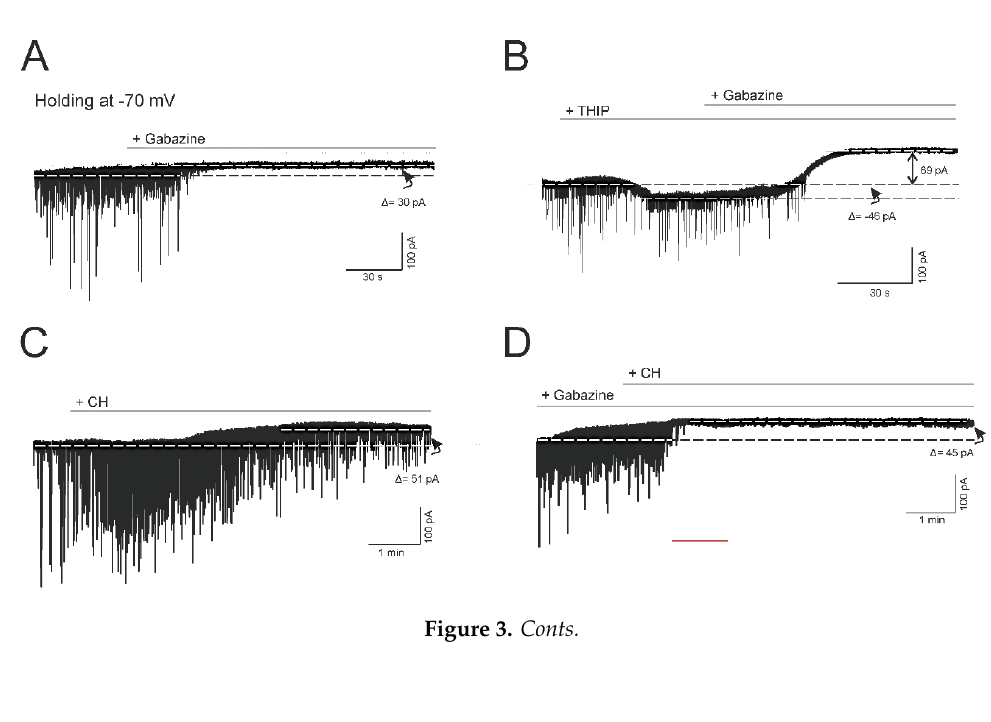
Figure 3. Effects of gabazine and cumene hydroperoxide (CH) on the holding current of pyramidal neurons from the motor cortex in infantile rats. ( A ) . The application of gabazine 20 μM ( n = 6) in the presence of glutamatergic antagonists blocked the spontaneous inhibitory postsynaptic currents (sIPSC) and revealed a tonic current mediated by the gabazine (GABA A ) receptor (30 pA for the illustrated neuron). ( B ). Changes in the holding current after THIP application (an agonist of GABA A extrasynaptic receptors) and after THIP plus gabazine in the same cell ( n = 6). These experiments were carried out to check the presence of extrasynaptic receptors in this pool of neurons. ( C ). Effect of CH on the membrane current. Note that the application of CH in the presence of CNQX and AP5 produced an outward shift in the holding current when the holding potential was held at −7 0 mV ( n = 6). ( D ). Effects on the membrane current during gabazine and CH consecutive application. Note that, in the same cell, no additional effects on the holding current were observed after CH administration. E-G. Histograms showing the mean values ( n = 6) of the changes in holding current after THIP and then after THIP plus gabazine in the same cells ( E ), after gabazine and after CH administration in different cells ( F ), and after gabazine and then after gabazine plus CH administration in the same cell ( G ). Note that no significant differences between both groups were found in F-G. THIP, Tetrahydroisoxazolo [5,4-c] pyridin-3-ol hydrochloride; CNQX, 6-cyano-7- nitroquinoxaline-2,3-dione; and AP5, d-amino-phosphonovalerato. 4.4. Exposure to CH Induced Lipid Peroxidation In order to understand the alterations in the response to CH in cells from different developmental stages, we measured lipid peroxidation ( n = 6 in each experimental group). Figure 4A